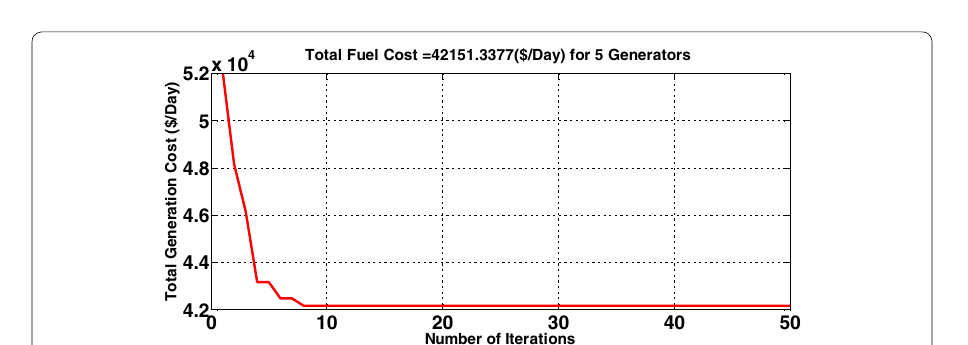
Fig. 3 Convergence graphs of test case 1